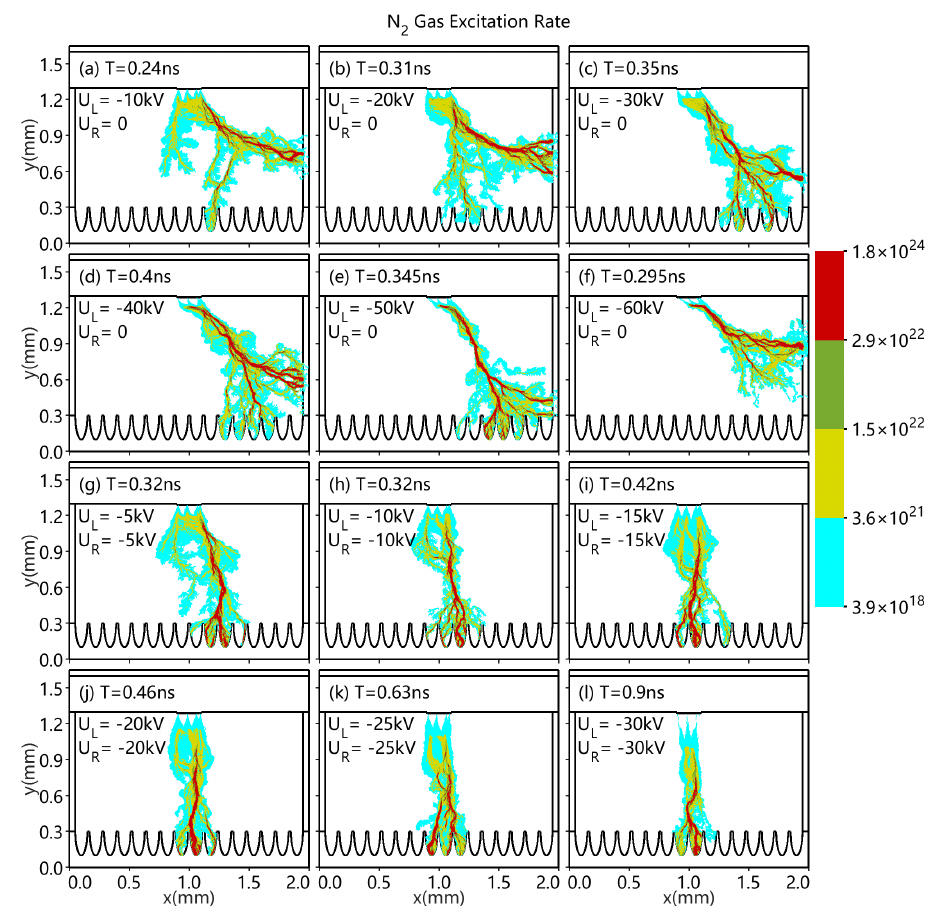
Figure 8. Distributions of electron-impact N 2 excitation rates (m − 3 s − 1 ) for different left and right voltages in DBD with ε r = 4 for both the top and bottom dielectric plates. The bottom dielectric plate has 16 pores. The diameter and depth of the catalyst pores are 0.1 mm and 0.2 mm, respectively. The voltage of the upper electrode ( y ∈ [ 1.60,1.65 ] mm) is − 20 kV. The voltages of left and right electrodes range from − 5 to − 60 kV. The bottom electrode ( y = 0 mm) is